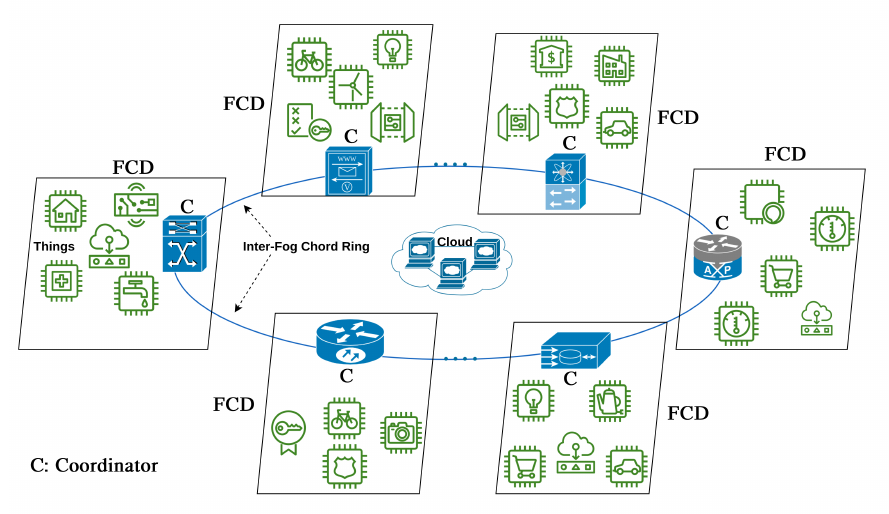
Figure 2. Proposed Chord-based Fog